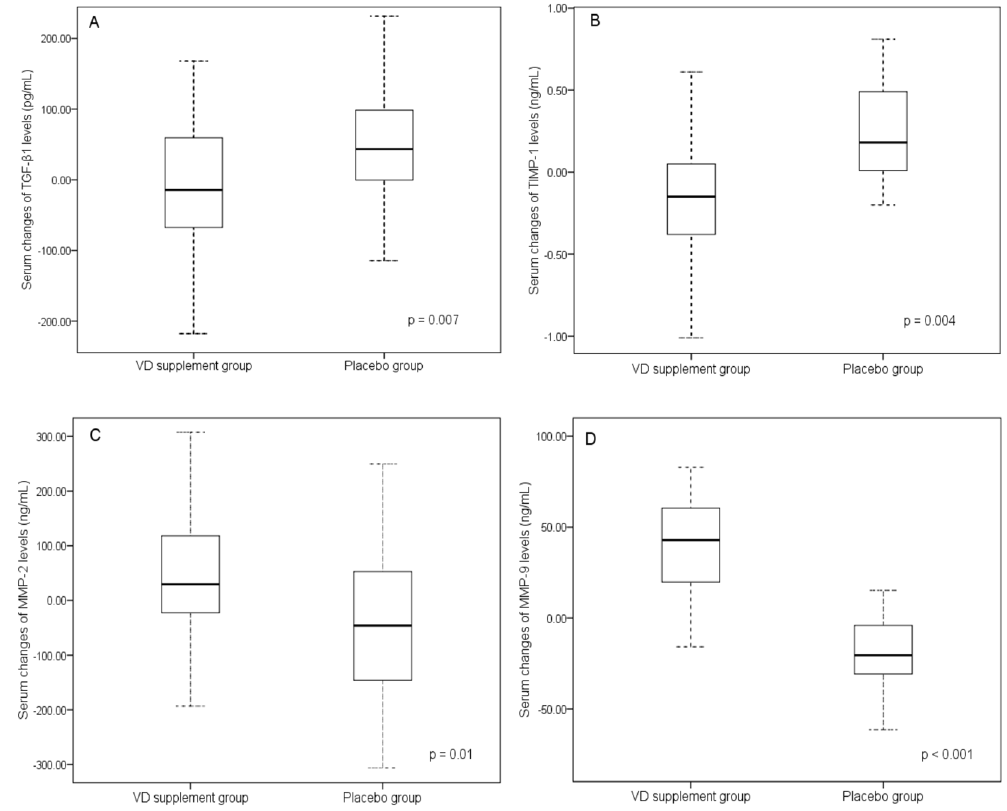
Figure 2. Box plot of mean differences (delta) in serum markers after 6-week supplementation with VD or placebo.